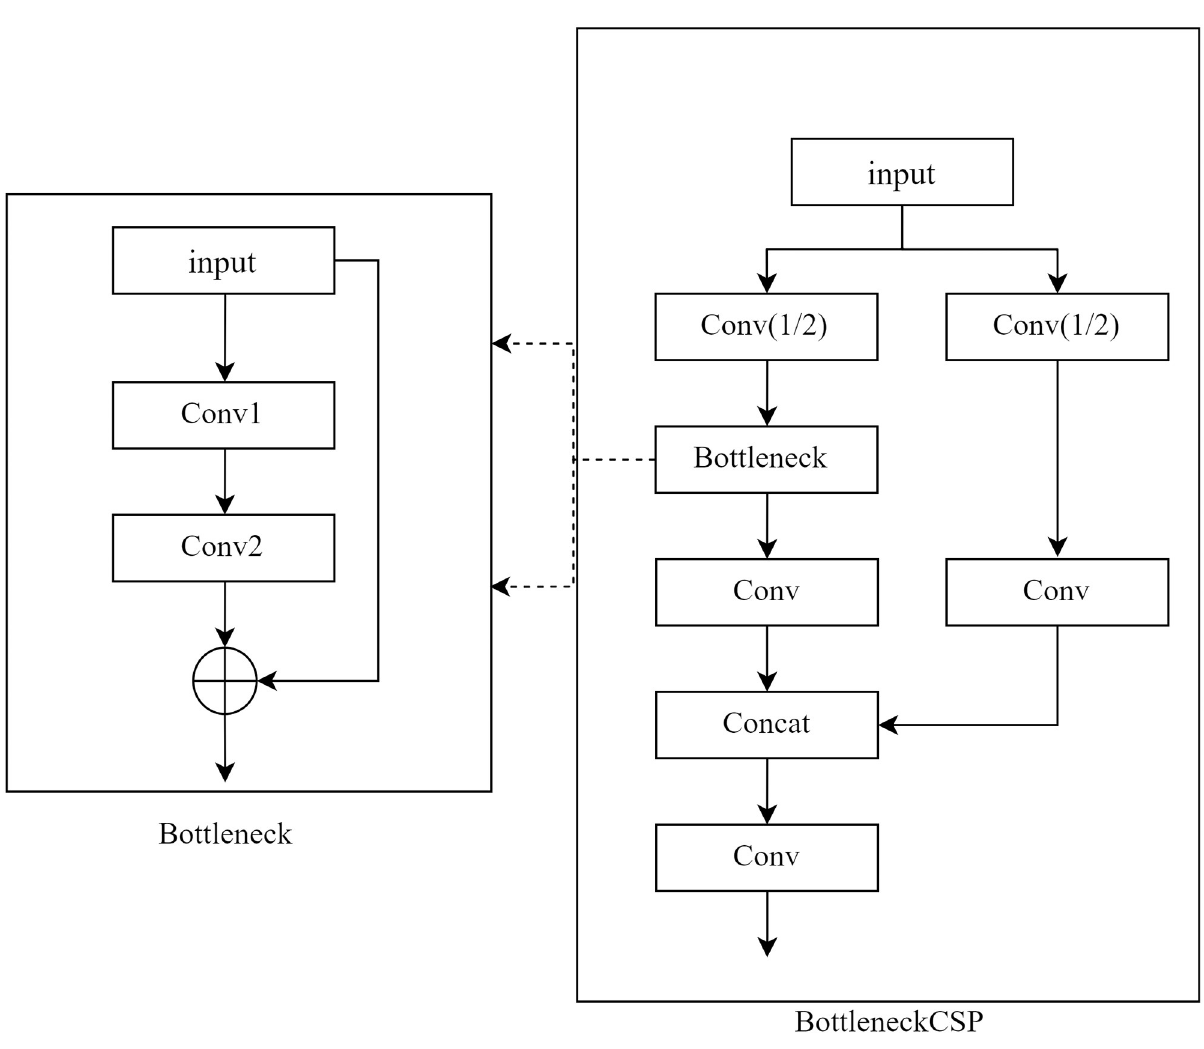
Fig 3. Schematic diagram of the structure of BottleneckCSP